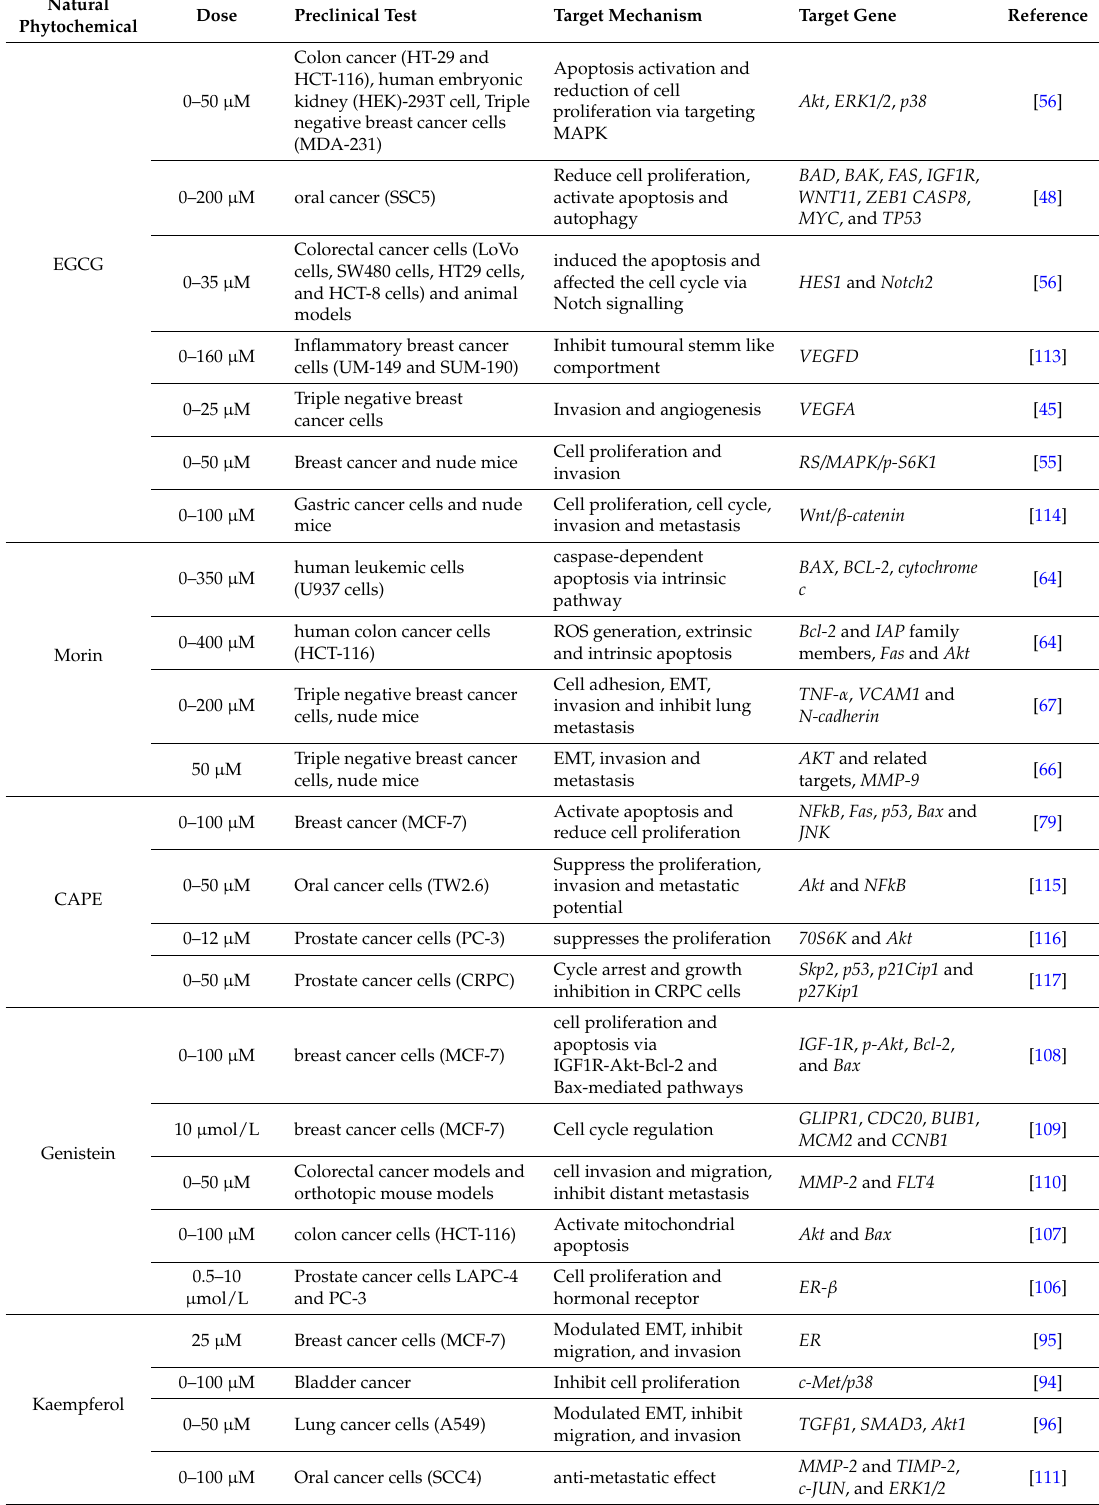
Table 1. Preclinical studies related to the implication of some relevant phytochemicals as antitumoral